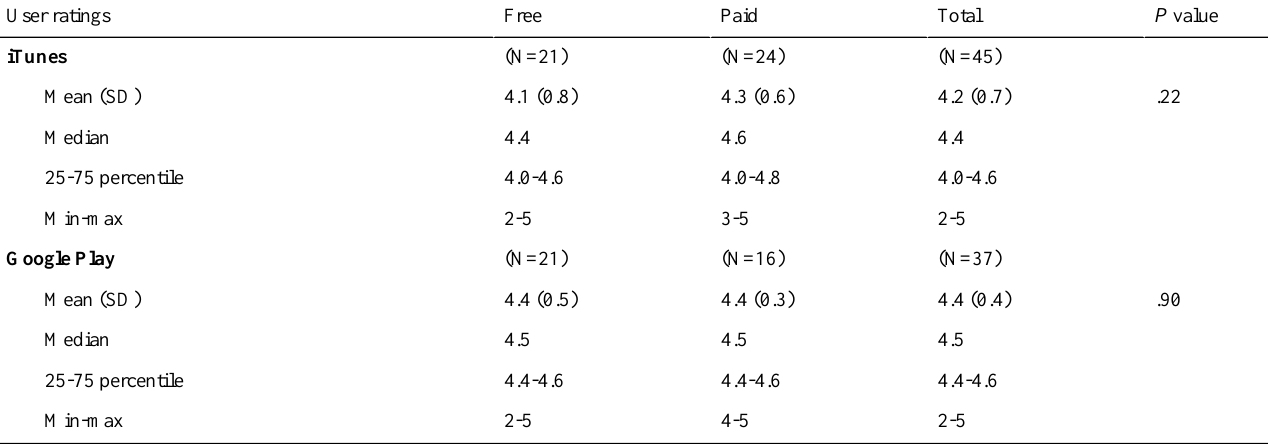
Table 7. Descriptive statistics for user ratings (1-5 stars) in iTunes and Google Play.